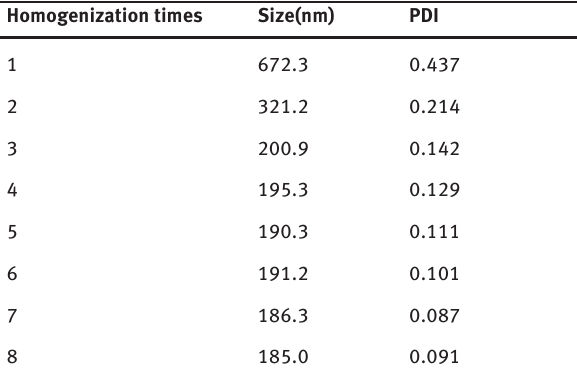
Table 4: Effect of cycle number of homogenization on the GB-LM preparation.